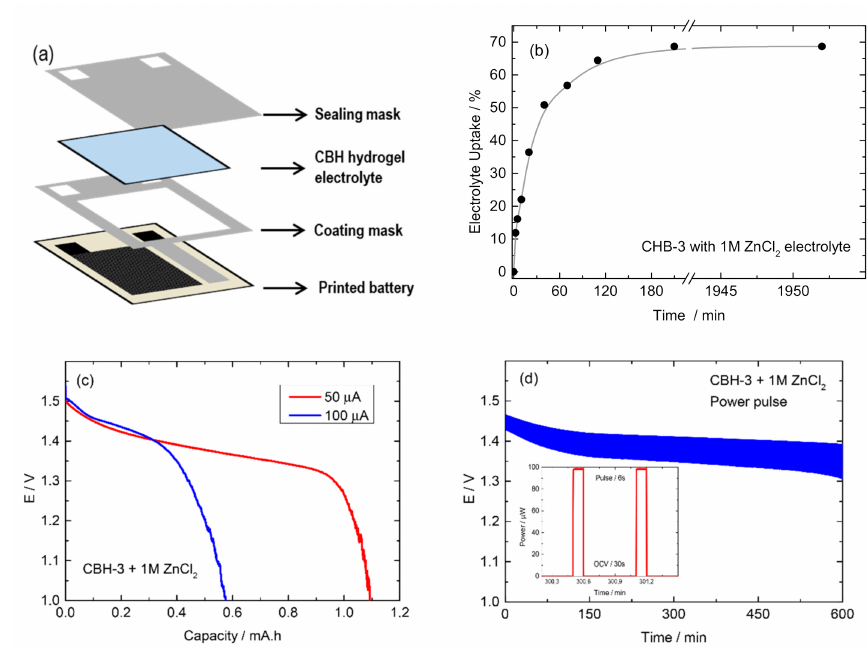
Figure 6. ( a ) Schematic representation of the coating procedure of cellulose-based hydrogel upon printed battery; ( b ) swelling behavior of CBH with 1 M ZnCl 2 electrolyte; ( c ) galvanostatic discharge curves of the printed battery with CBH-3 swelled in 1 M ZnCl 2; ( d ) intermittent discharge profile via power pulses (6 s: 100 µ W; 30 s: open circuit potential (OCV)) of the battery with CBH-3 swelled in 1 M ZnCl 2